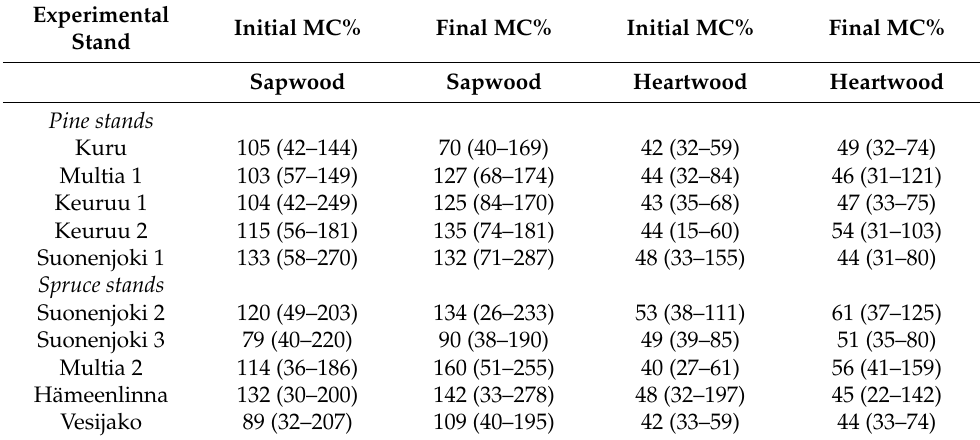
Figure 4. Area covered by Heterobasidion sp. (%) in pine stumps as a function of stump diameter in different treatments (control, P. gigantea , or urea) after ( a ) thinning, ( b ) cap cutting, and ( c ) clear- cutting. Predicted values based on linear mixed models have been used to draw the figure. Comparing the pooled data by tree species, the initial moisture content measured before the treatment was significantly higher in pine than in spruce sapwood, i.e., mean 116 and 100%, respectively (t = 4.422, df = 357.840, p < 0.001) while the moisture content of heartwood did not differ significantly between spruce and pine, i.e., 46 and 45%, respec- tively (t = − 0.862, df = 359, p = 0.389). Detailed information on the stump moisture contents is given in Table 4. Table 4. Initial and final moisture contents (MC%) of sapwood and heartwood are given as a mean (range in parenthesis) in experimental